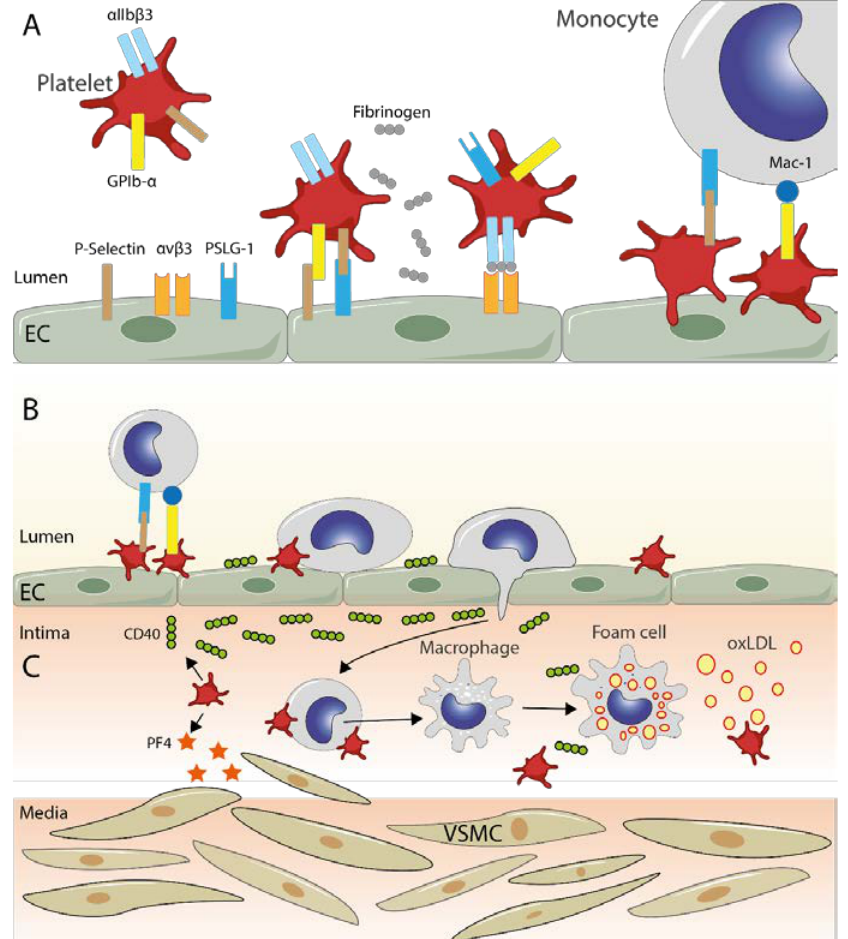
Figure 1. Transendothelial migration of monocytes and platelets. ( A ) Turbulent blood flows or pro- atherogenic metabolic conditions, among other factors, trigger the expression of adhesion molecules by activated endothelial cells, ultimately leading to platelet adhesion and activation. First, there is a binding between endothelial P-selectin and platelet GPIb- α, which is reinforced by the binding of P-selectin and P-selectin glycoprotein ligand (PSLG-1), expressed on activated platelets and endothelial cells, respectively. A more stable binding, mediated by fibronectin (gray chained circles), is established between integrin α v β 3 of endothelial cells and α IIb β 3 of platelets. Once platelets have attached to the activated endothelium, they can function as a bridge between monocytes and endothelial cells thanks to the interactions between PSLG-1 and P-selectin, and between Mac-1 and GPIb- α , promoting the migration of monocytes into the intima ( B ). ( C ) Platelets can also modulate the composition of the intimal layer of blood vessels by releasing CD40 (green chained circles), which favors increased migration of monocytes and their transformation into foam cells by the inclusion of oxidated LDL (yellow circles). As shown, platelets can release Platelet Factor 4 (PF4, orange stars), which, among other effects, allows the recruitment of vascular smooth muscle cells (VSMC), favoring their proliferation and change to a proinflammatory